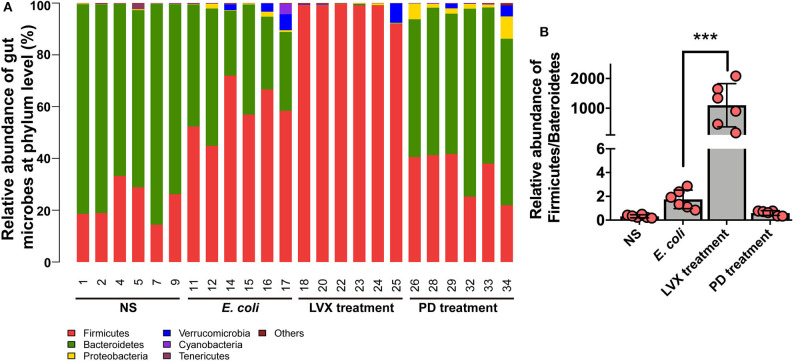
Microbial composition of PD or LVX treatment at the phylum level. (A) Distribution of bacterial taxa under PD or LVX treatment at the phylum level. Sequences that could not be classified into any known group were designated as “unclassified”. (B) Relative abundance of Firmicutes/Bacteroidetes under PD or LVX treatment. Date showed the mean ± SD (***P < 0.001, n = 6).